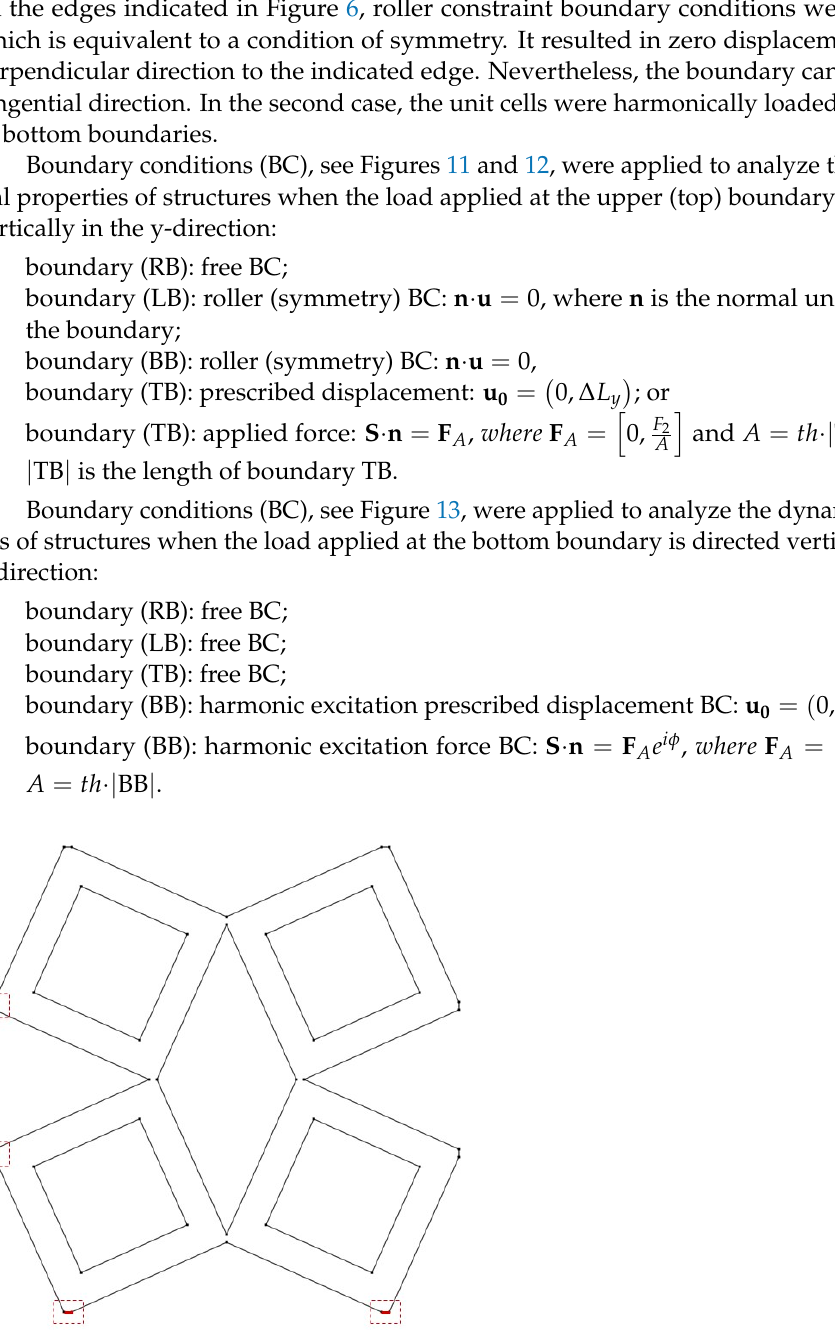
Figure 12. Considered load scenario for evaluation of effective structure properties. Free boundary condition is applied for the remaining boundaries. Figure 13. Considered load scenario for evaluation the dynamic characteristic of the structure. Free boundary condition is applied for the remaining boundaries.